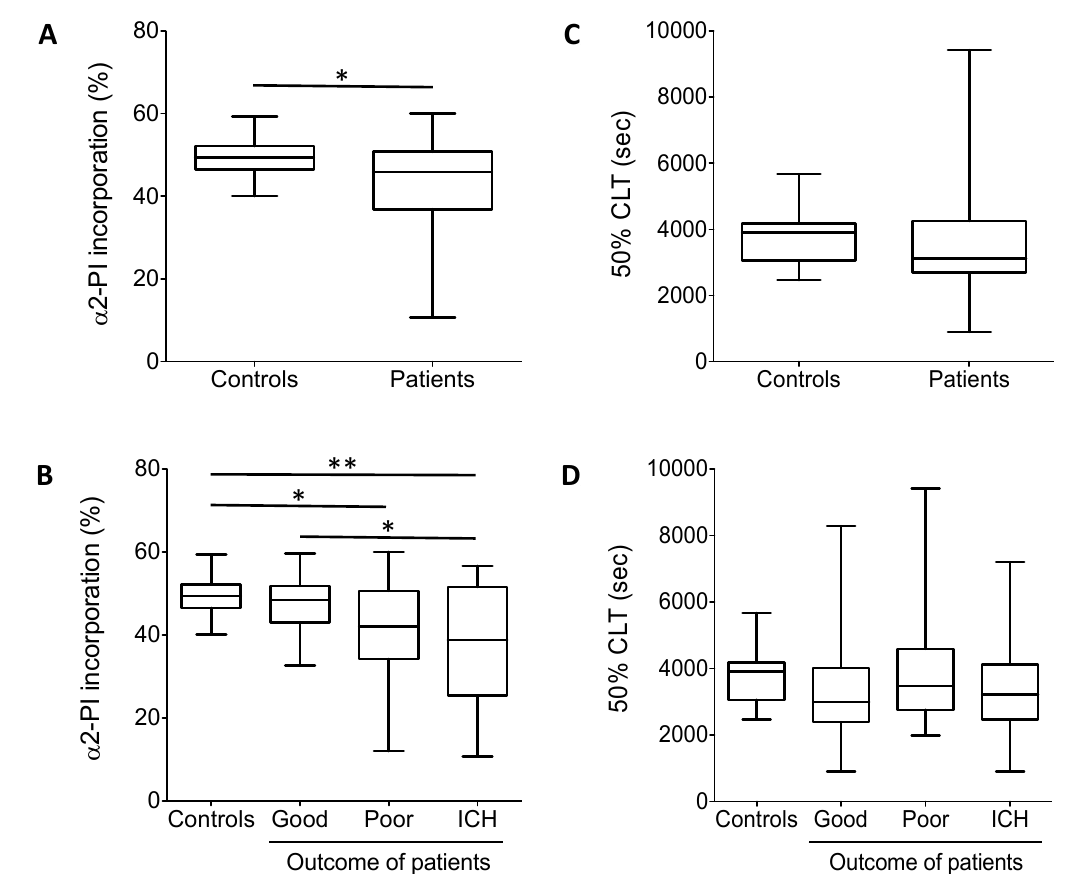
Figure 3. ( A ) α2-PI incorporation into the fibrin clot. Plasma samples were clotted by thrombin and Ca 2+ . Differences between plasma and serum α2-PI antigen values were calculated and incorporation was presented as percentage of the respective plasma values in controls and in the total cohort of patients. ( B ) α2-PI incorporation into the fibrin clot in controls and in patients according to different outcomes. ( C ) In vitro clot lysis experiments. The 50% CLT parameter is shown in controls and in the total cohort of patients. The 50% clot lysis times (CLTs) did not show significant differences between controls and patients. ( D ) In vitro clot lysis experiments in controls and in patients according to different outcomes. The 50% CLT did not show significant differences among patient groups. Box and whisker plots indicate median, interquartile range, and total range *, p < 0.05; **, p < 0.01.